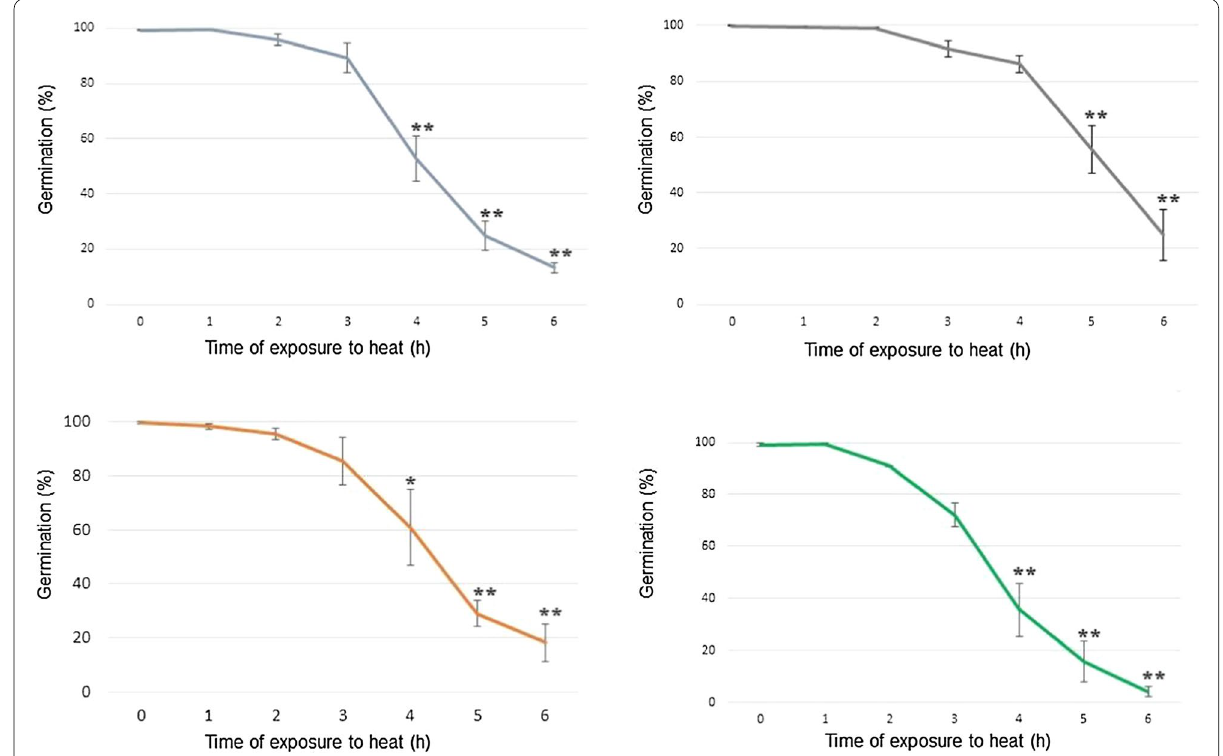
Fig. 2 Relative viability (%) of Metarhizium robertsii ARSEF 2575 produced in parboiled rice supplemented or unsupplemented with riboflavin and sodium nitrate after exposure to heat stress. Rice was washed with Tween 80 ® (0.01% v/v) after twenty days of solid fermentation. The groups evaluated were: A: Crude extract produced in supplemented medium; B: Conidia produced in supplemented medium; C: Crude extract produced in unsupplemented medium; D: Conidia produced in unsupplemented medium. Samples of each group were exposed to 45 of exposure an aliquot was inoculated in culture medium for germination analysis. All exposure times were compared to the 0 h of heat exposure. *P < 0.05 and **P < 0.01 according to Tukey’s